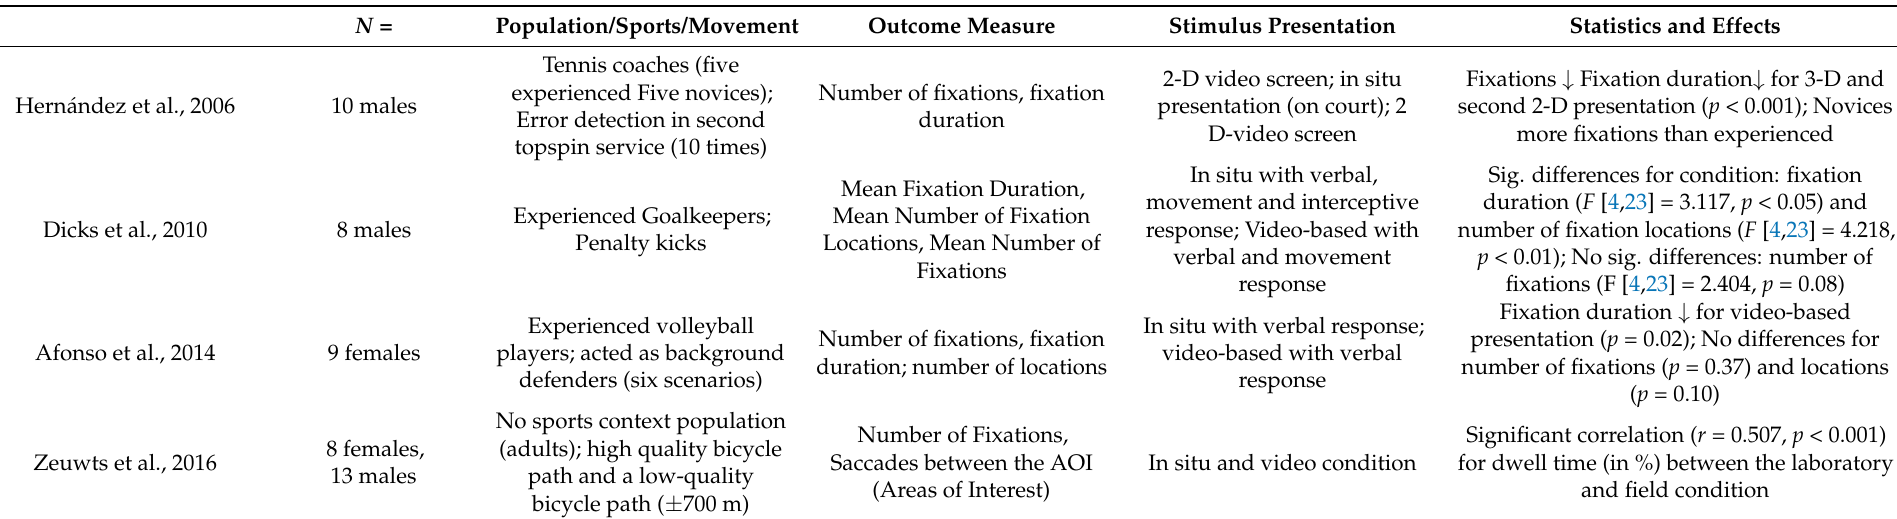
Table 1. Articles thematize differences between video and in situ stimulus